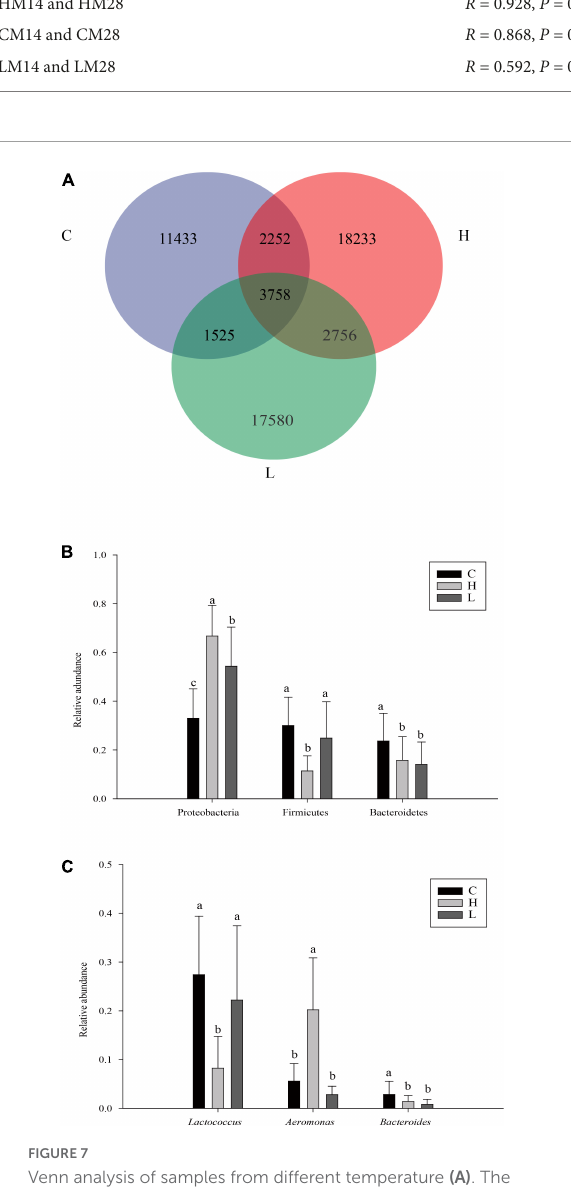
FIGURE7 Venn analysis of samples from different temperature (A) . The relative abundances of dominant phylum (B) and genus (C) of Pomacea canaliculata intestine microbiome at different temperature group (Duncan’s post hoc test, a = 0.05; a > b > c). The C, H, and L represented the control group, high and low temperature groups treated for 14 and 28 days,